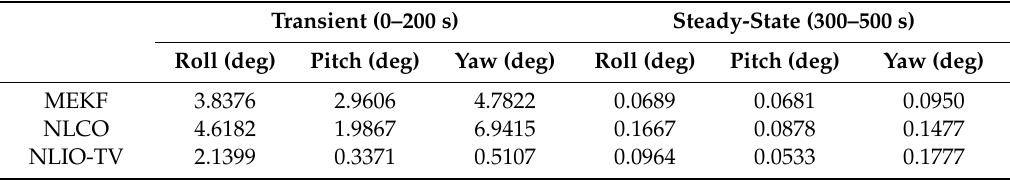
Table 6. MAEs of attitude for all observers.